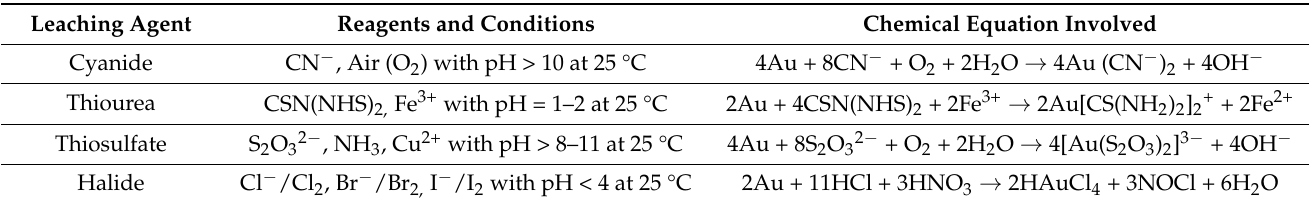
Table 6. Methods of leaching gold from e-waste [85].